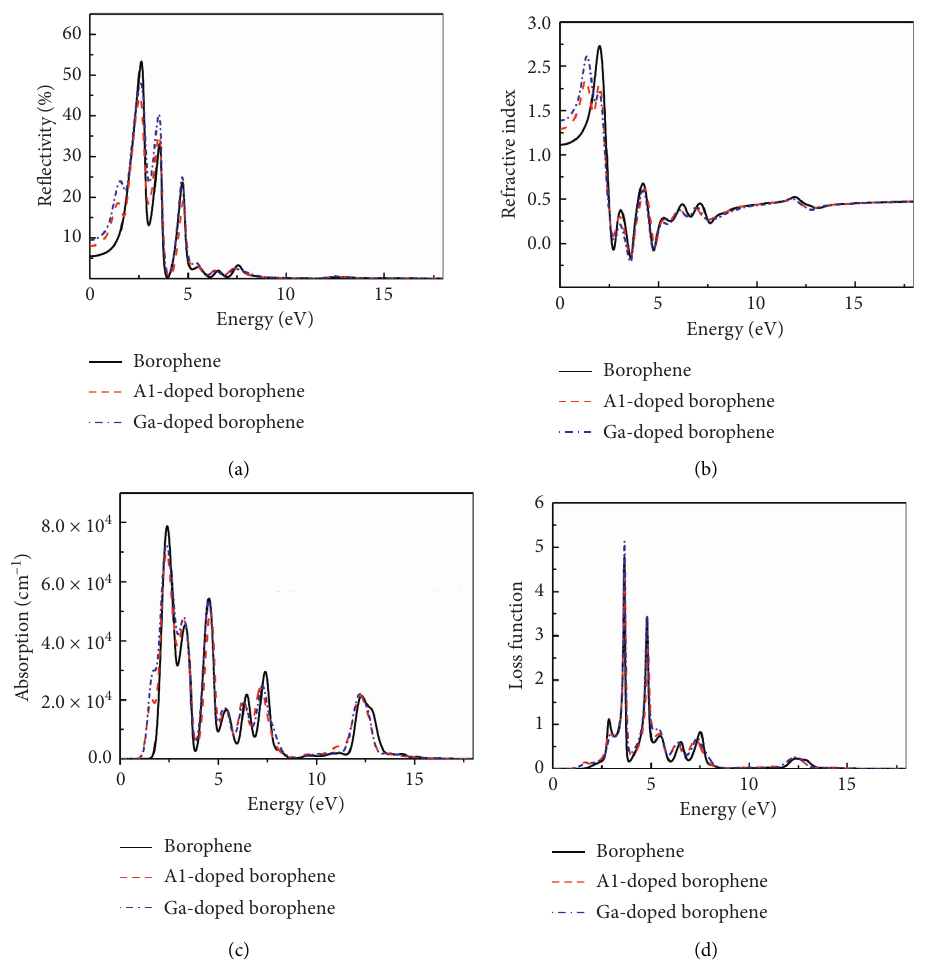
Figure 6: Optical properties of borophene. (a) Reflectivity. (b) Refractive index. (c) Absorption. (d) Loss